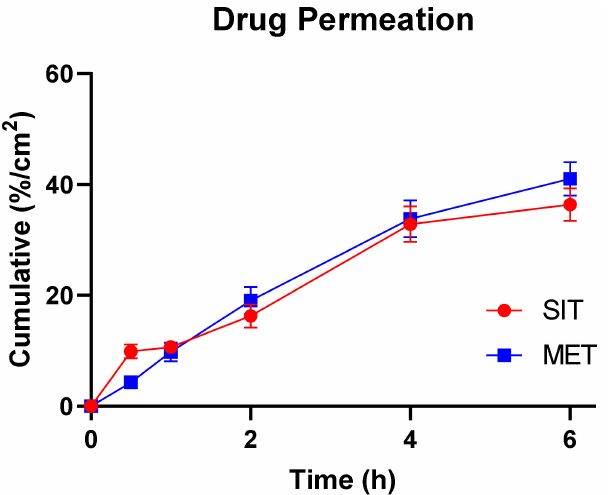
Figure 10. Cumulative percentage of drugs permeated through the unit area of rabbit buccal mucosa from the optimized formulation.